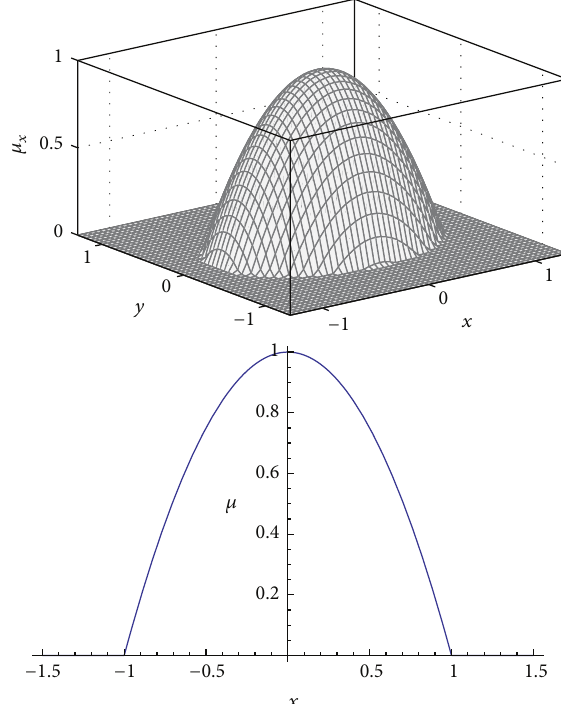
Figure 2: Membership function of z and x ,